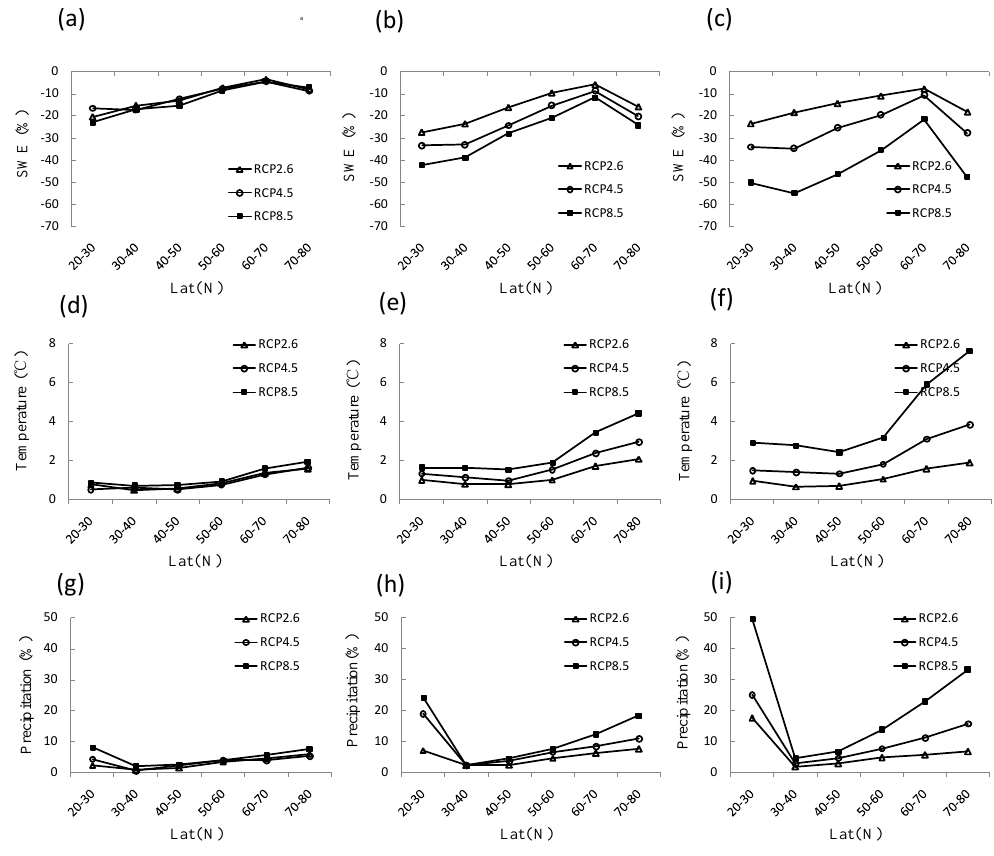
Figure 4. Projected change in zonally averaged mean annual SWE (a–c) , mean annual air temperature (d–f) and mean annual precipitation (g–i) over Northern Hemisphere land for 2016–2035 (left), 2046–2065 (middle), and 2080–2099 (right) relative to the 1986–2005 reference period. Table 2. Zonally averaged slope (Slop, kgm − 2 ◦ C − 1 ) and correlation (Cor.) from the regression of mean annual SWE and temperature for three RCPs. RP, EP, MP, and LP represent the periods 1986–2005, 2016–2035, 2046–2065, and 2080–2099,